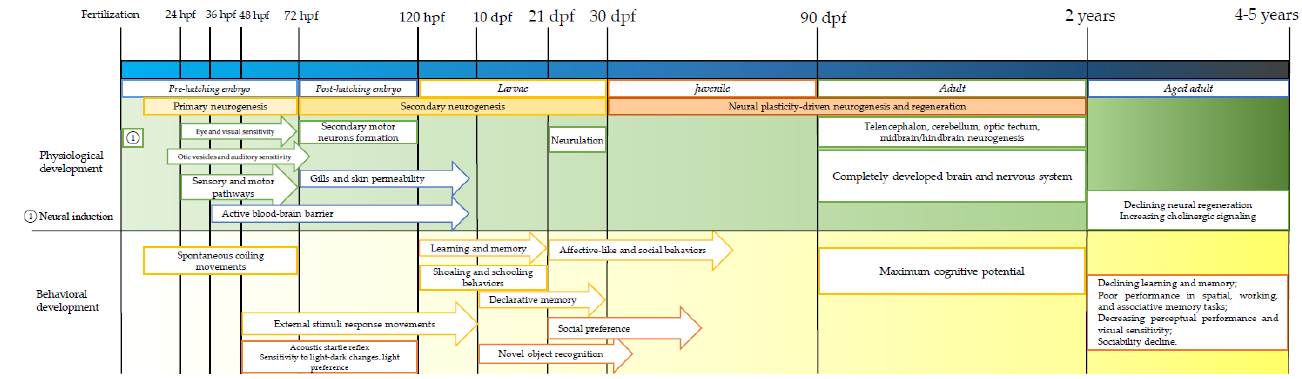
Figure 1. Neurophysiological and behavioral development of zebrafish [54,89 – 91].